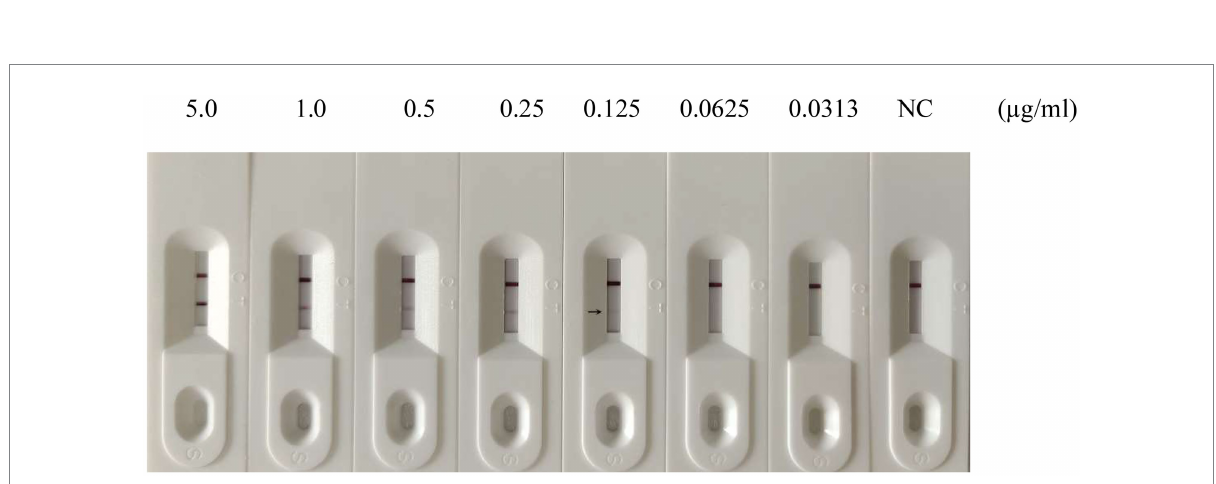
FIGURE 5 Sensitivity of the GICA strip for detecting rPDCoV-N protein. Different concentrations of the protein (5.0, 1.0, 0.5, 0.25, 0.125, 0.0625 and 0.0313 μ g/ ml) were detected by the strip. PBS was used as the negative control